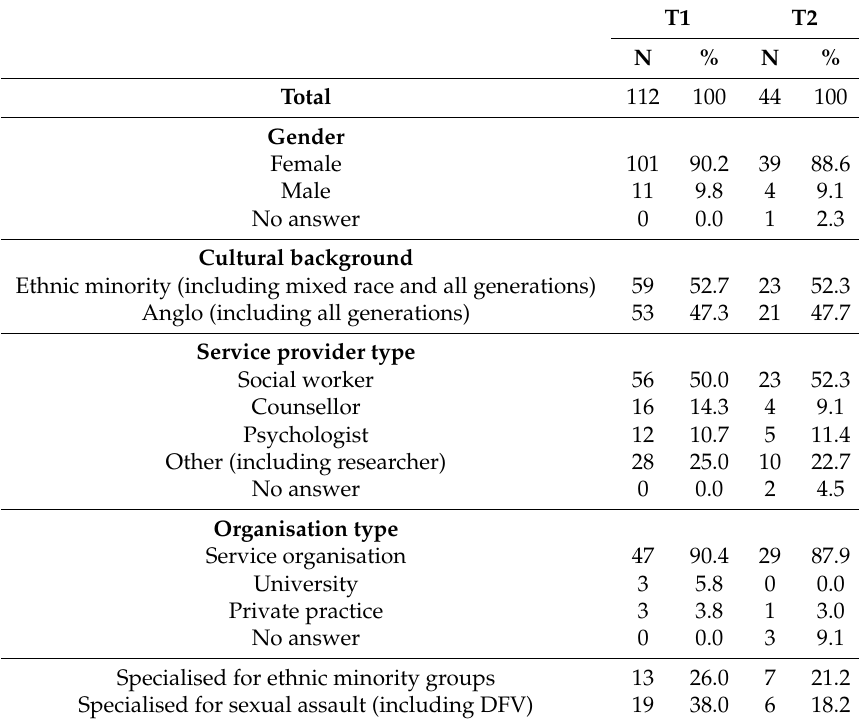
Table 2. Frequency sample